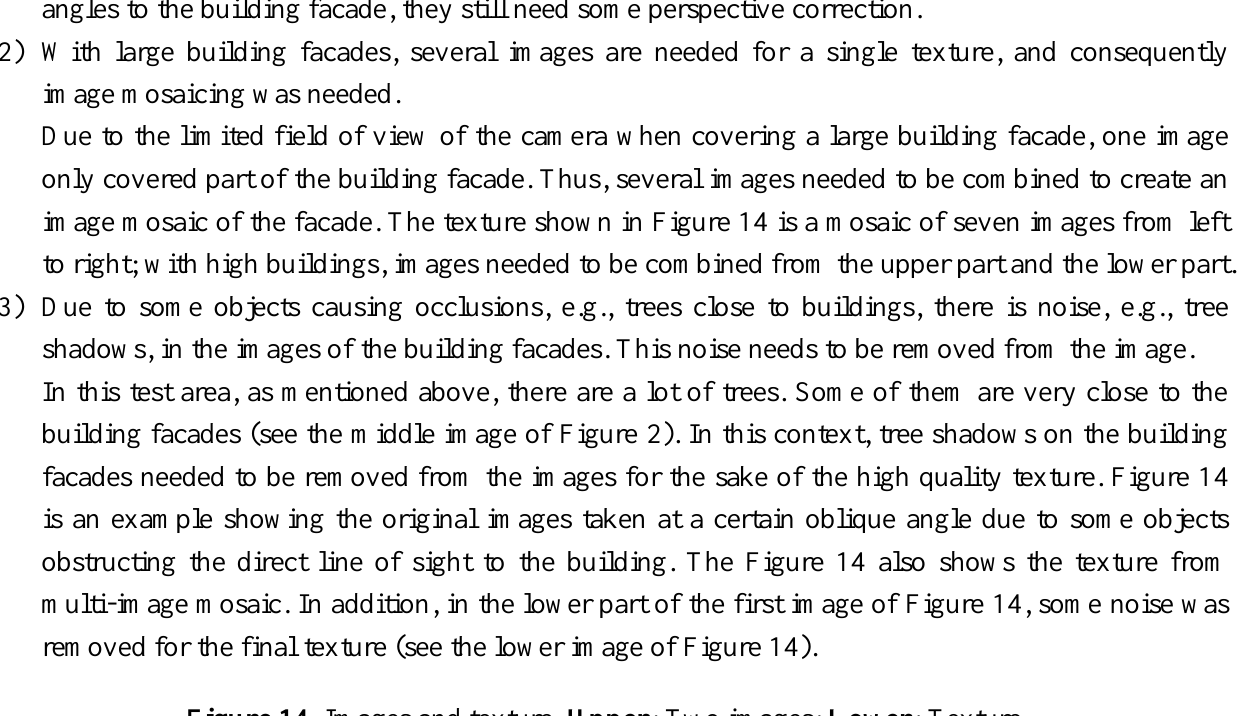
Figure 14. Images and texture. Upper : Two images; Lower :